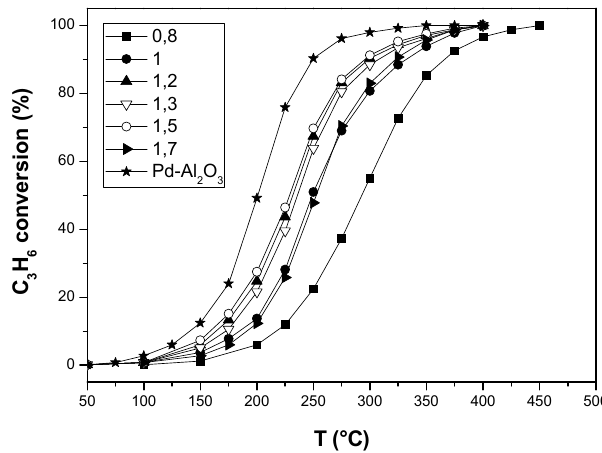
Figure 11. Propene conversion versus temperature during the second consecutive run (cooling ramp). The inlet gas composition: 1000 ppm propene and synthetic air (80/20 vol %) with a total flow of 100 mL × min − 1